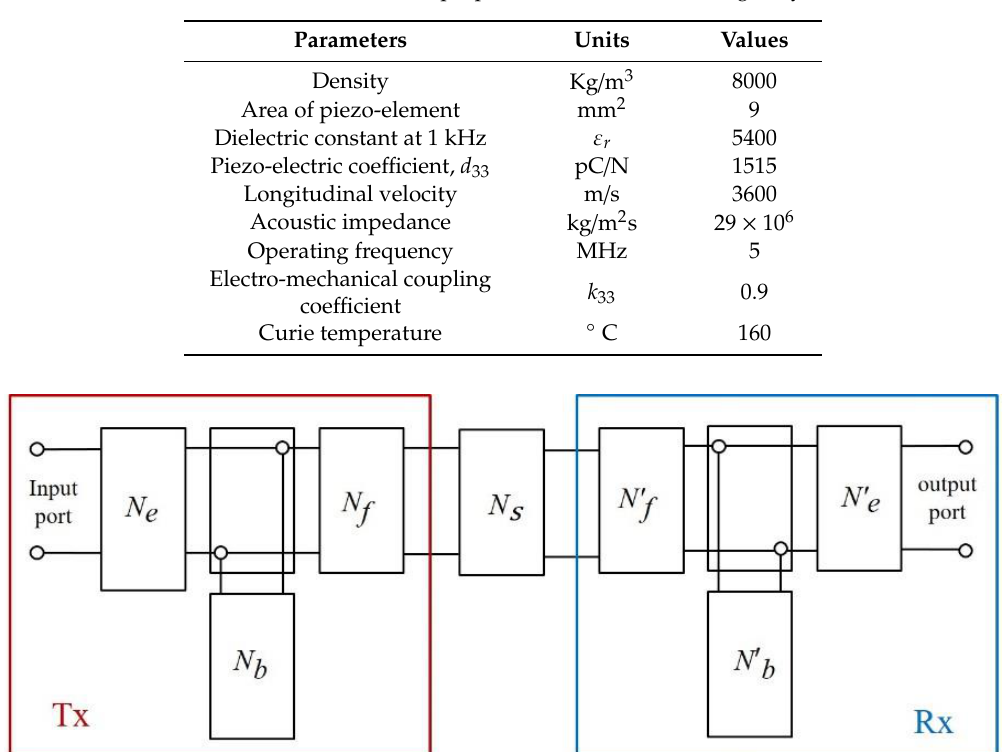
Table 2. Measured material properties of PMN-28%PT single crystal.